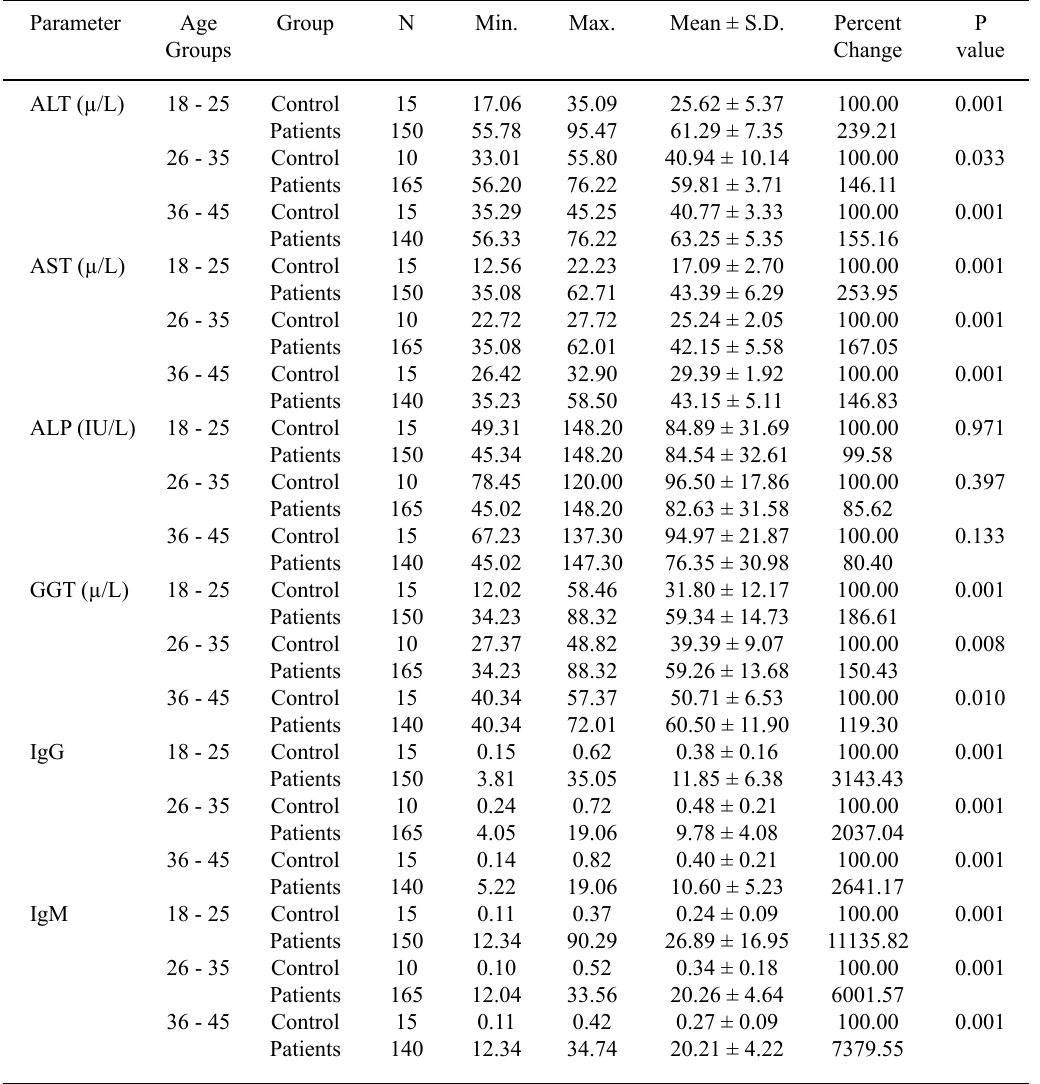
Table 1. Comparisons of aLT, asT, aLP, ggT, Igg and IgM in the three studied age groups of CMV seropositive patients compared to healthy control